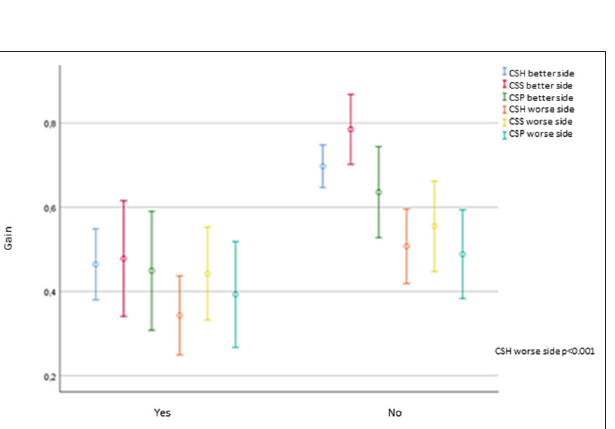
FIGURE 4 | Distribution of the different etiologies according to the fulfillment of Barany’s diagnostic criteria for BVH.